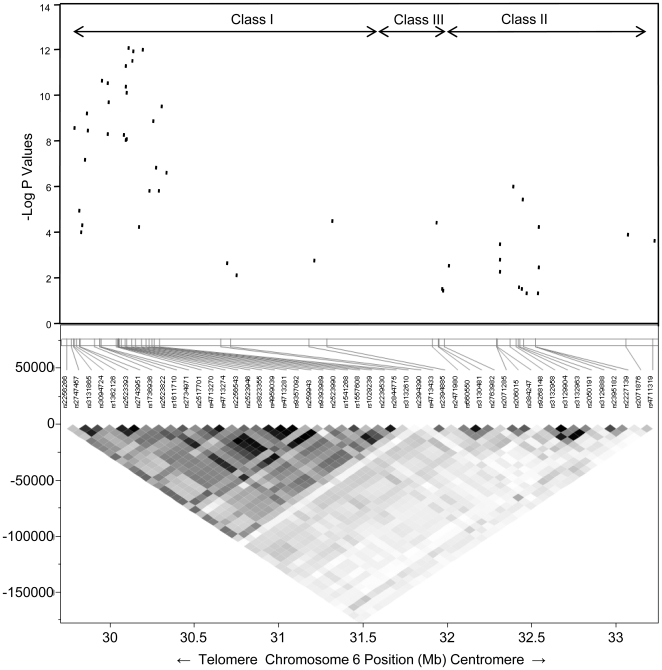
LD map and associations for the 48 SNPs in the merged dataset that excludes all HLA-DRB1*15:01 subjects.Each SNP's position in the MHC is shown on the X-axis with the most telomeric SNPs on the left and the most centromeric SNPs on the right. The lower portion of the figure depicts the strength of LD is in intensity from black to grey to white. Multiple SNPs in the Class I region associated with MS susceptibility independently from HLA-DRB1*15:01 are in moderate to strong LD with each other. These SNPs are in much weaker LD with the MS associated SNPs in the Class III and Class II regions. The degree of statistical significance is depicted in the upper portion of the figure where each SNP's –log10 transformed p-value is depicted on the Y-axis. The most significant associations with MS susceptibility are in the Class I region and the Class III and Class II signals, although statistically significant, are considerably weaker. An algorithm used to cluster SNPs based on LD-R2
[15] grouped together SNPs in the Class III NOTCH4 gene (rs2071285, rs206015, rs384247) and Class II gene TSBP (rs9268148, rs3132958, rs3129904, rs3132963, rs2050191).